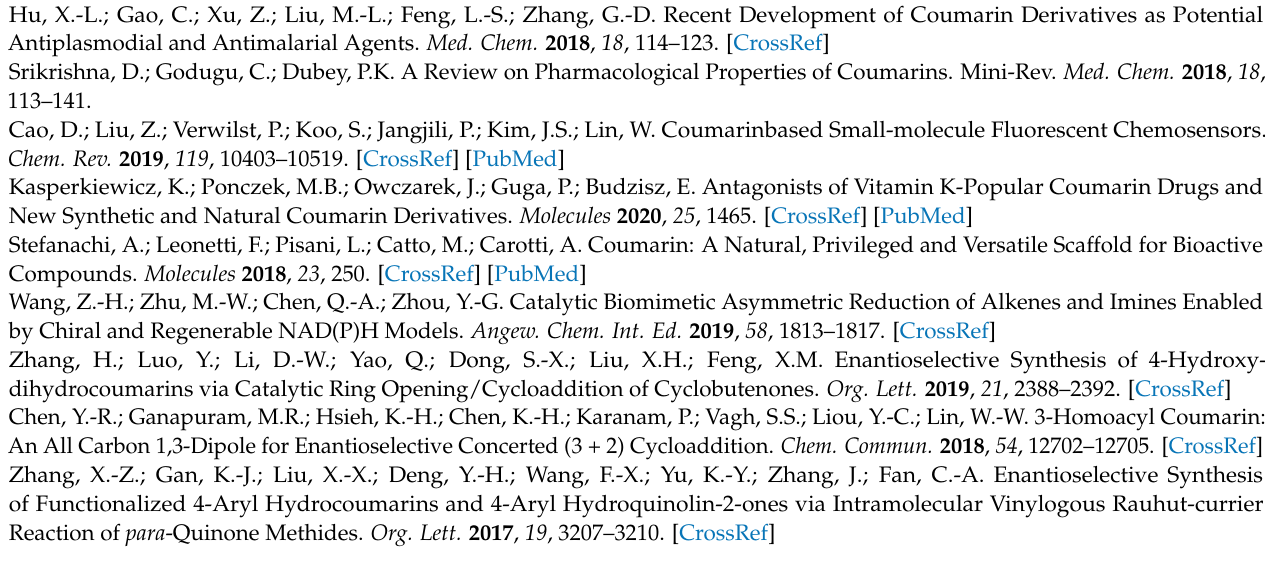
Supplementary Materials: The following are available online: 1 H and 13 C NMR spectra and HPLC data of compounds 3a–p and 5